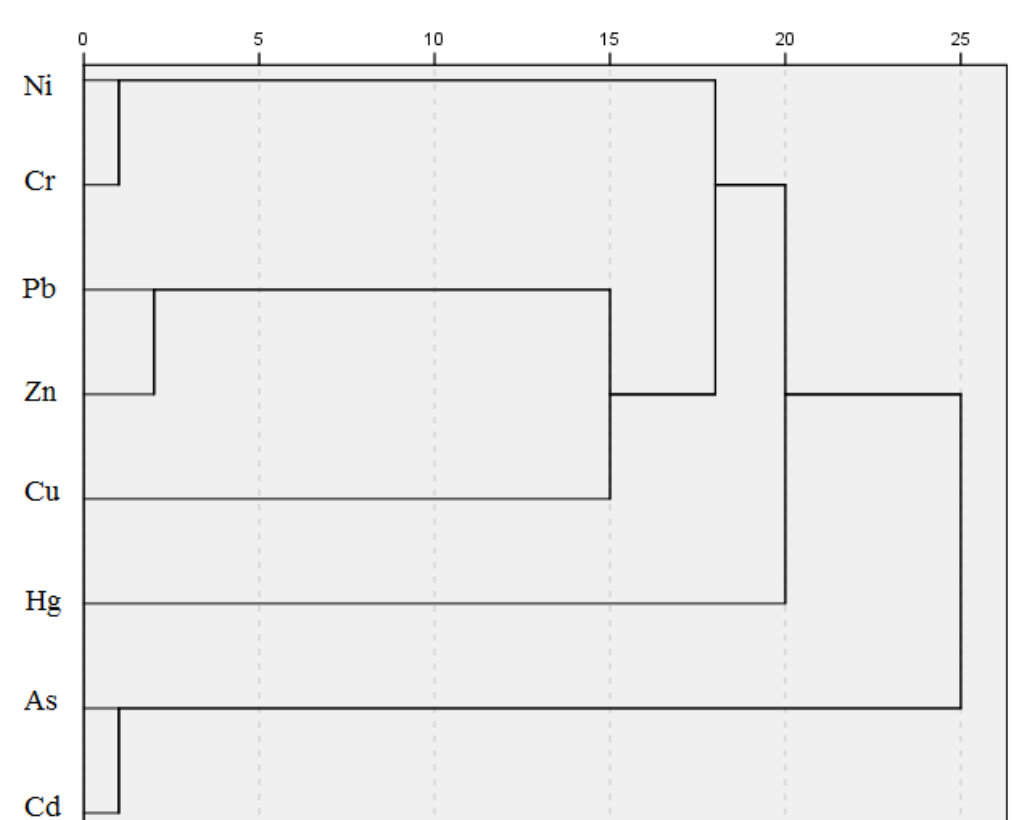
Figure 3. Dendrograms produced by hierarchical